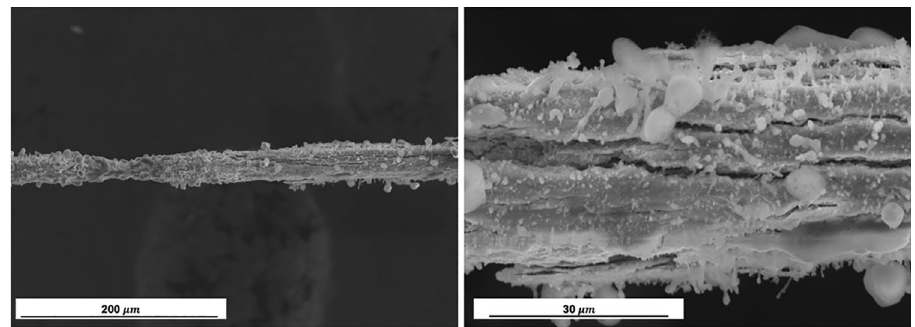
Figure 9. Thickness change of W wire of 25 µm after 300 h in service due to erosion and corrosion triggered in the process. There is a reduction in section that may be due to the combination of localized detachment by micro-arcs. Also due to plastic deformation favored by focused temperature increases in specific arc-areas. Necking has been observed in some filaments without appreciable